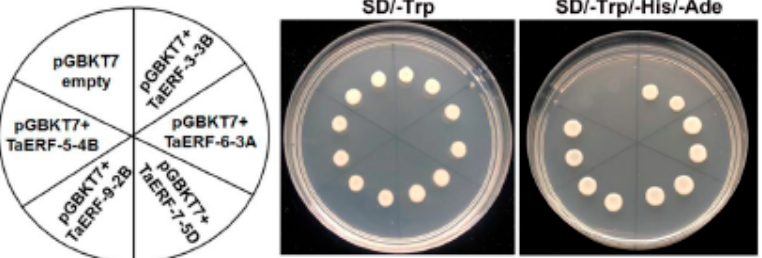
Figure 7. Transcriptional activation of five TaAP2/ERF proteins. The ORF fragments of TaAP2/ERF genes were ligated with pGBKT7 to construct a fusion vector. The yeast cells harboring TaAP2/ERF fusion vectors were cultured on the SD/-Trp and SD/-Trp/-His/-Ade.